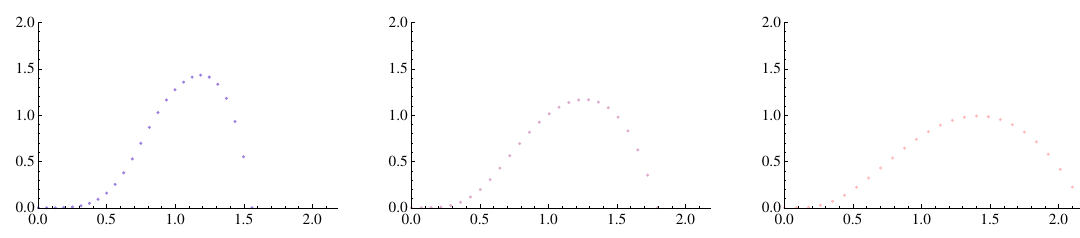
Figure 5 . Three separate plots of the probability density vs (cid:18)=(cid:18) 0 each for di(cid:11)erent times. From left to right (cid:28) = : 14 ; 0 : 34 ; 4 :